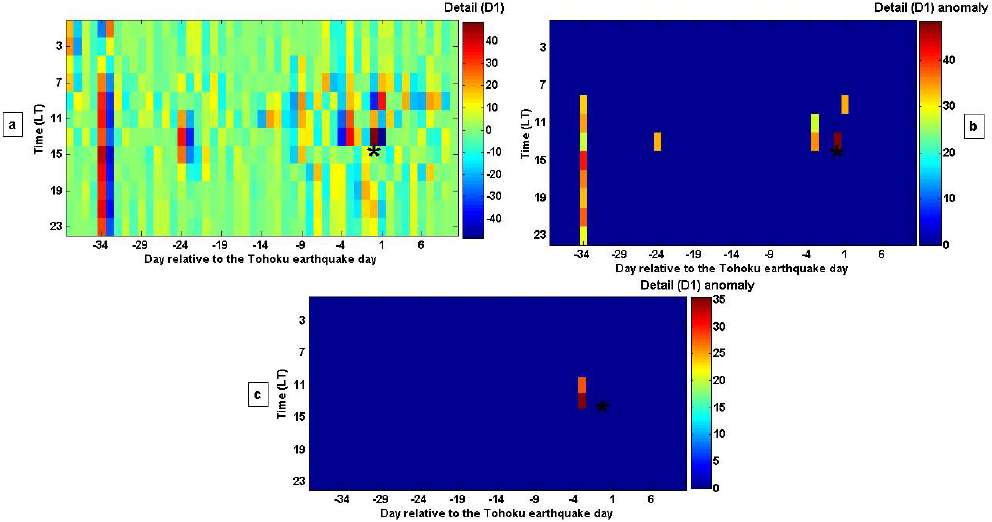
Fig. 5. Results of analysis for the Tohoku earthquake using the detail coefficients of the wavelet transform method, (a) TEC variations after executing the method, (b) detected TEC anomalies without considering the geomagnetic conditions and (c) detected TEC anomalies during quiet geomagnetic